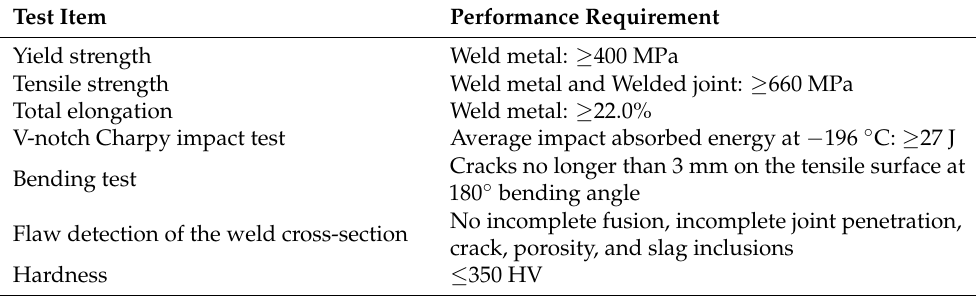
Table 1. Welding process approval test items and related evaluation